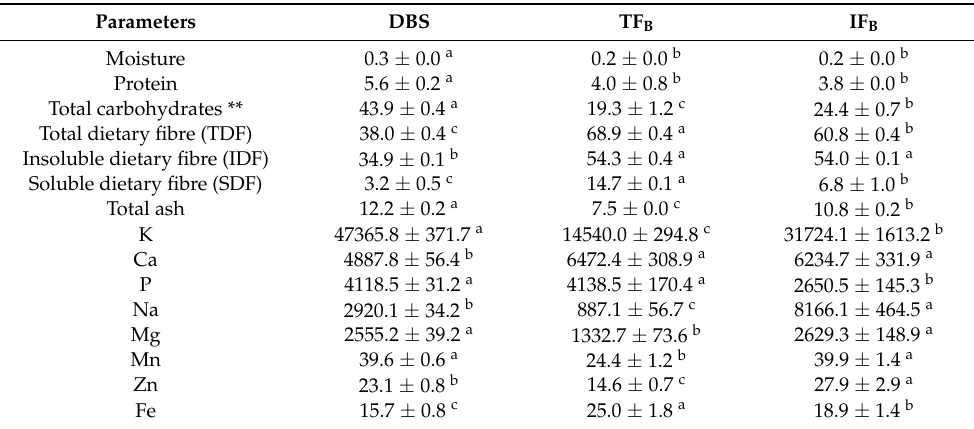
Table 1. Nutritional composition, expressed as percentage or g/100 g d.w., and mineral composition (mg/kg) of different samples obtained from broccoli stalk